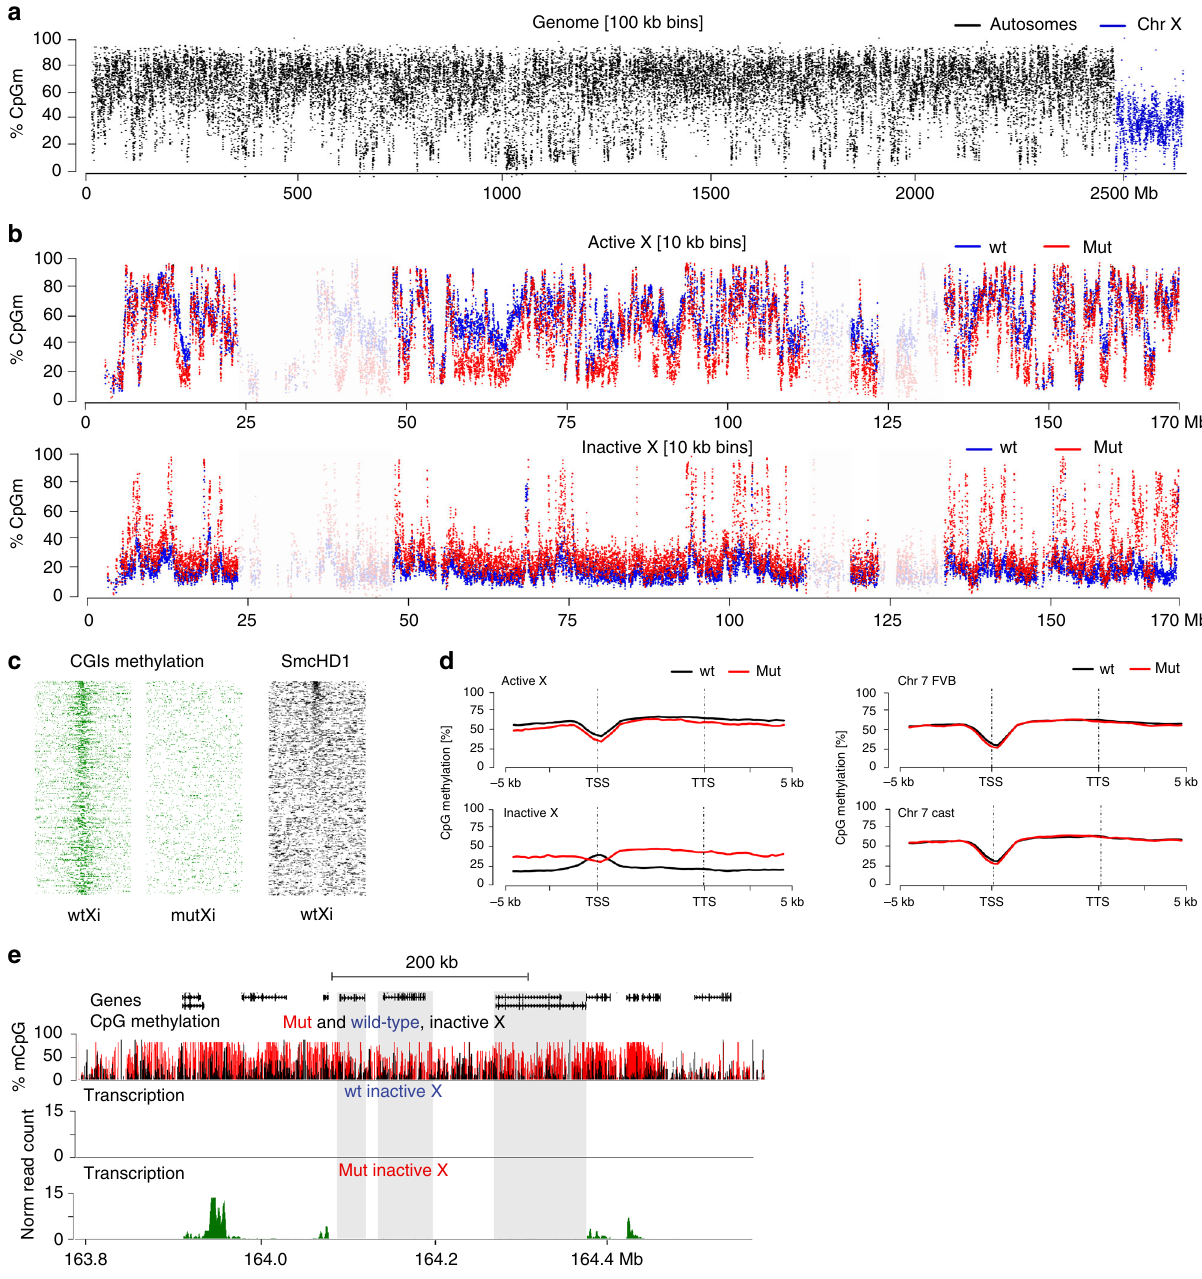
Fig. 2 The Xi methylome in wt and SmcHD1 mutant MEFs. a WGBS reads binned into 100 kb intervals illustrating reduced level of CpG methylation on the X chromosome relative to autosomes. b Allele-speci fi c DNA methylation pro fi le of Xa (top) and Xi (bottom) in wt and germline SmcHD1 mutant (mut) MEFs plotted as % of CpGm averaged within 10 kb bins. Regions of low mappability are indicated with reduced colour intensity. c DNA methylation of CGIs on wt and mut Xi (left) and SmcHD1 occupancy (right). CGIs in all heatmaps sorted according to the SmcHD1 enrichment. d Metagene plots of DNA methylation in wt and mut MEFs generated for Xa and Xi as well as for maternal and paternal Chr7. e Example of a hypermethylated domain on Xi in mut cells, showing that the region of high DNA methylation extends beyond expressed genes to encompass genes that are silenced. Non-expressed genes with DNA methylation above the background level are highlighted with shadowed boxes NATURE COMMUNICATIONS| (2019) 10:30